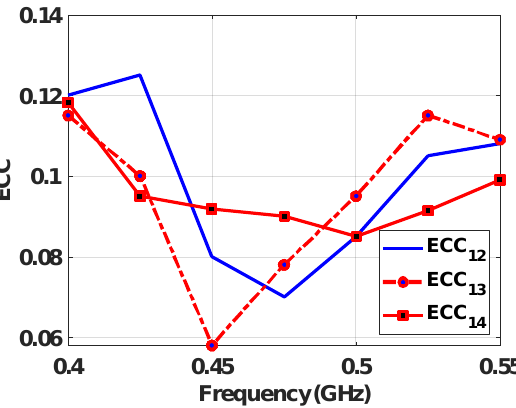
Figure 9. ECC between various antenna elements of the proposed CubeSat MIMO antenna.